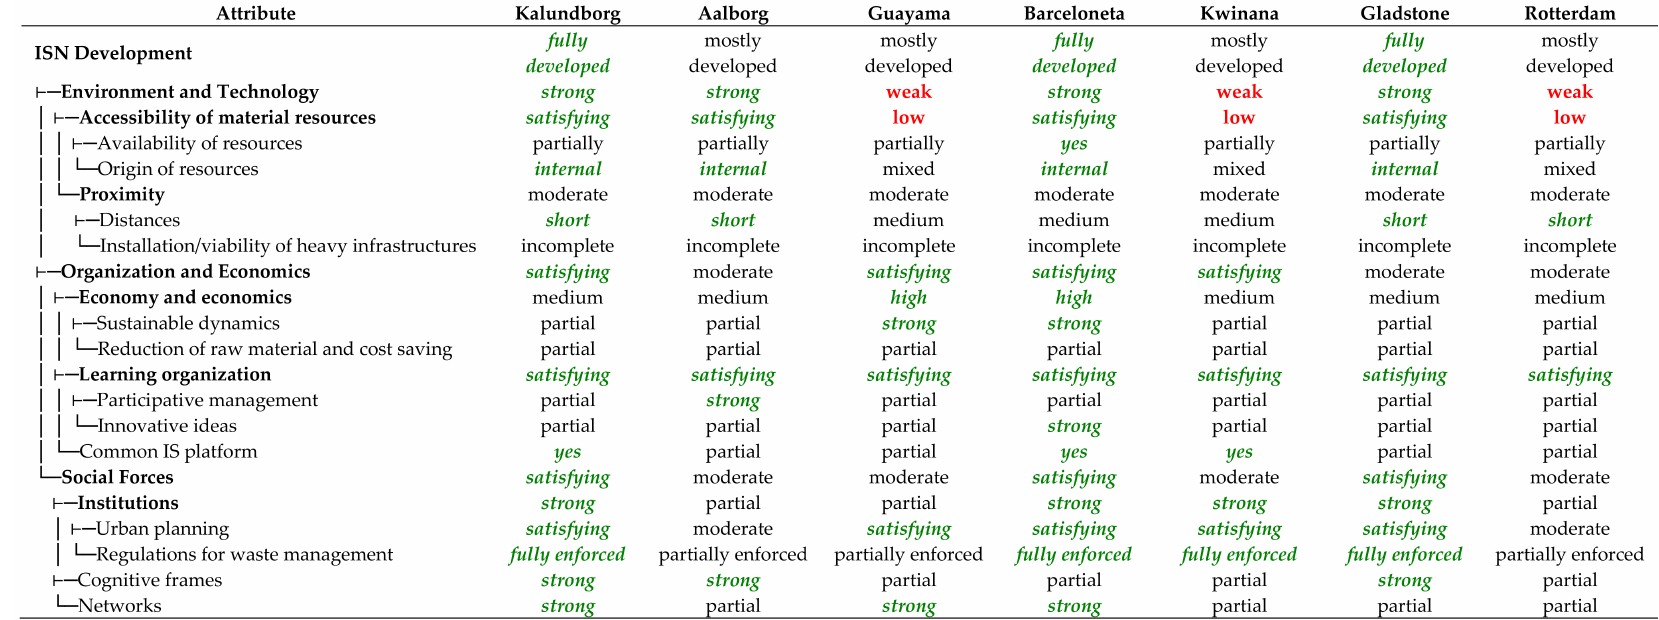
Table 2. DEX model and evaluation of seven IS cases shows that three of the seven IS cases are evaluated with highest qualitative measure as “fully developed”, while four IS cases are evaluated as “partially developed”. Such evaluation is in line with the information from the considered